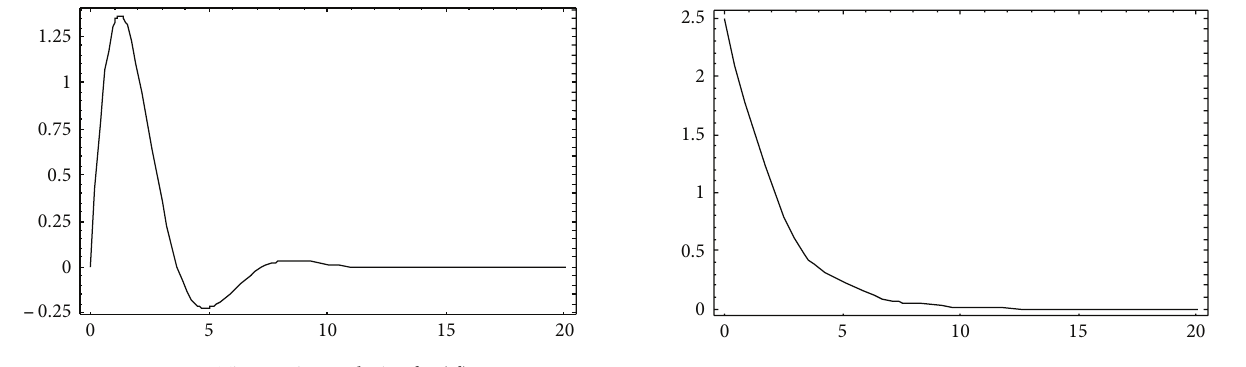
Figure 12: Convergence of errors in